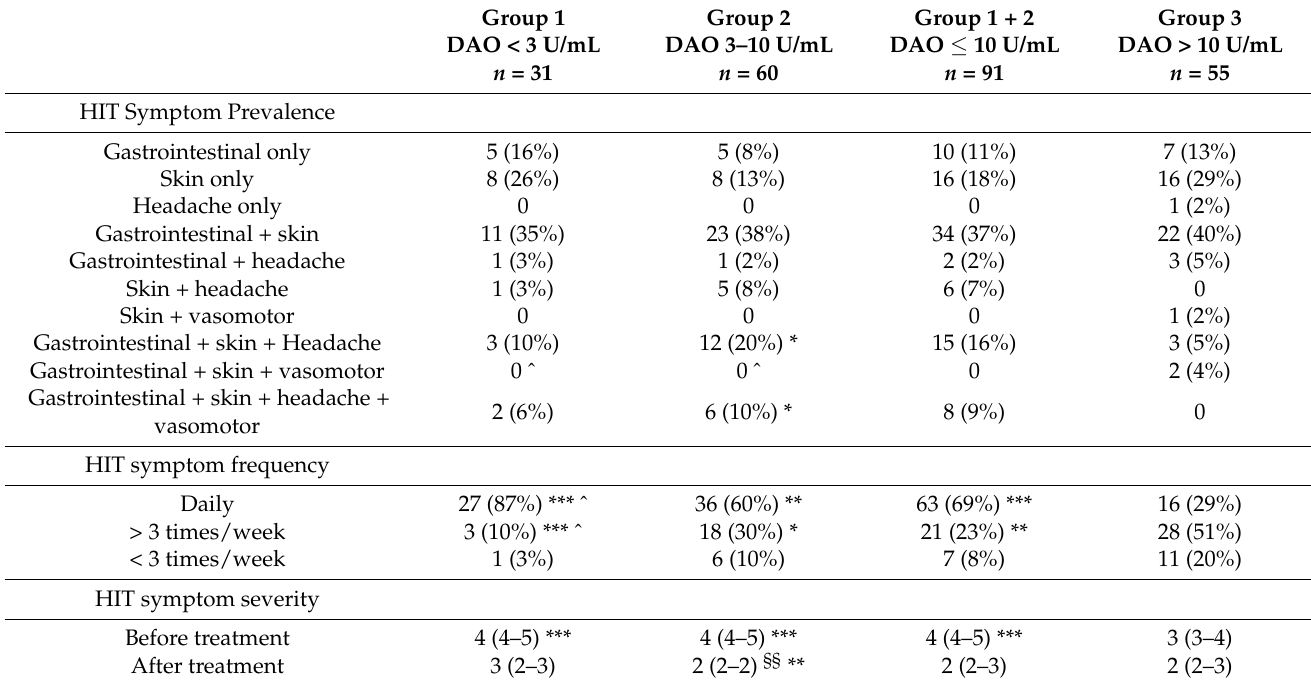
Table 2. HIT clinical